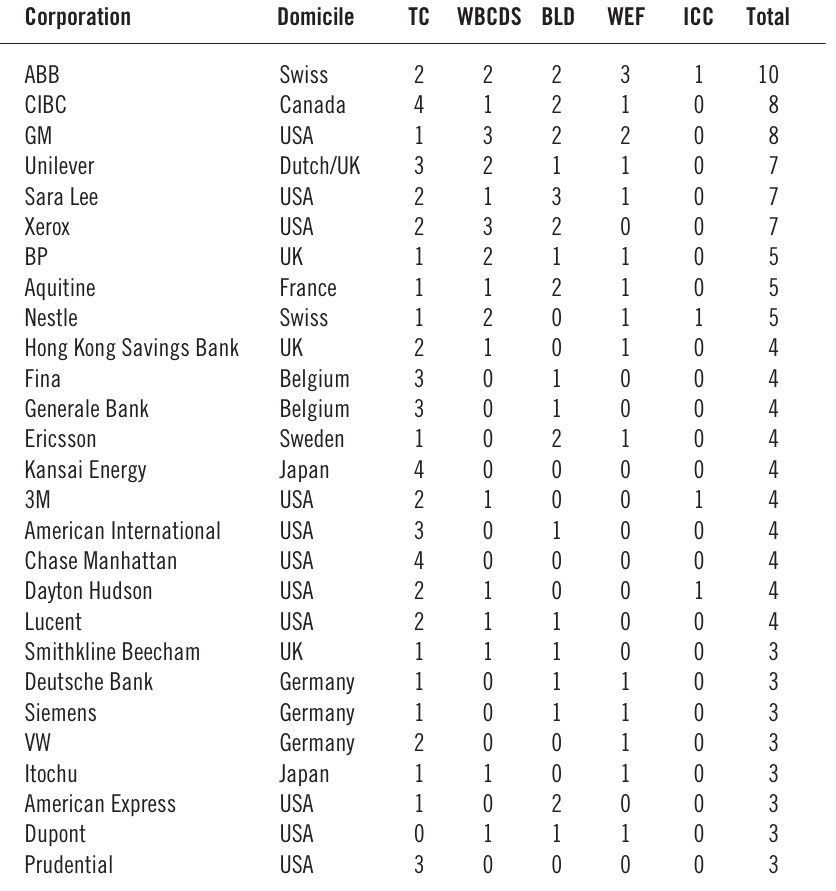
Table 4 – Numbers of Corporate Directors on Five Global Policy Boards, 1996 Figure 4 – Interlocks Among Five Global Policy Groups and 27 Centrally- Positioned